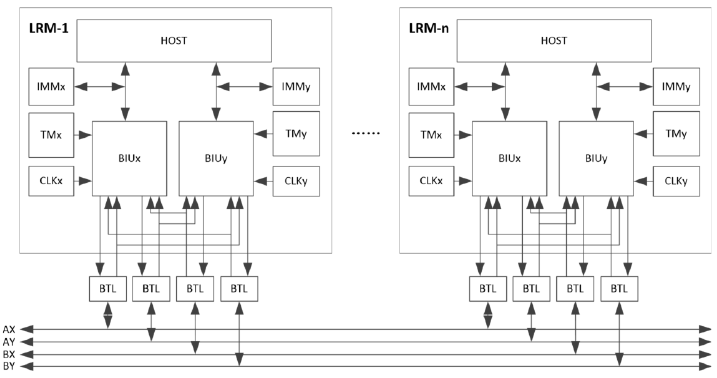
Figure 1. Schematic of the ARINC 659 bus.